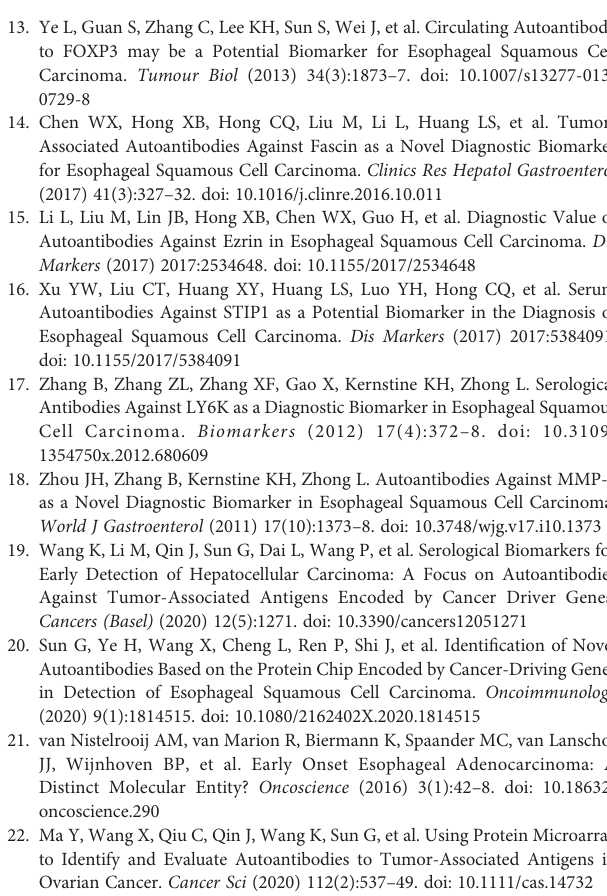
Supplementary Figure 1 | The expression of GNA11 protein in the tissues of different